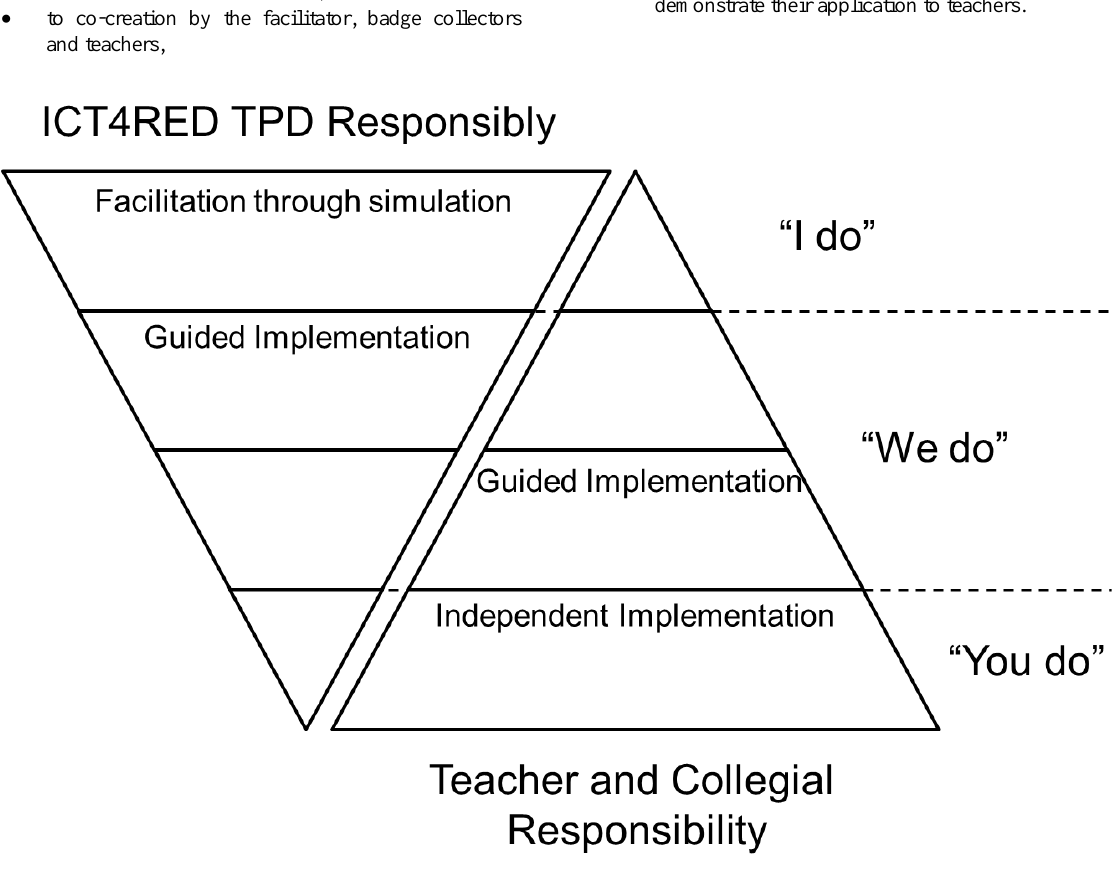
Figure 1 ICT4RED TPD process (adapted from Gradual Release of Responsibility Instruction Framework Pearson (Pearson & Gallagher,